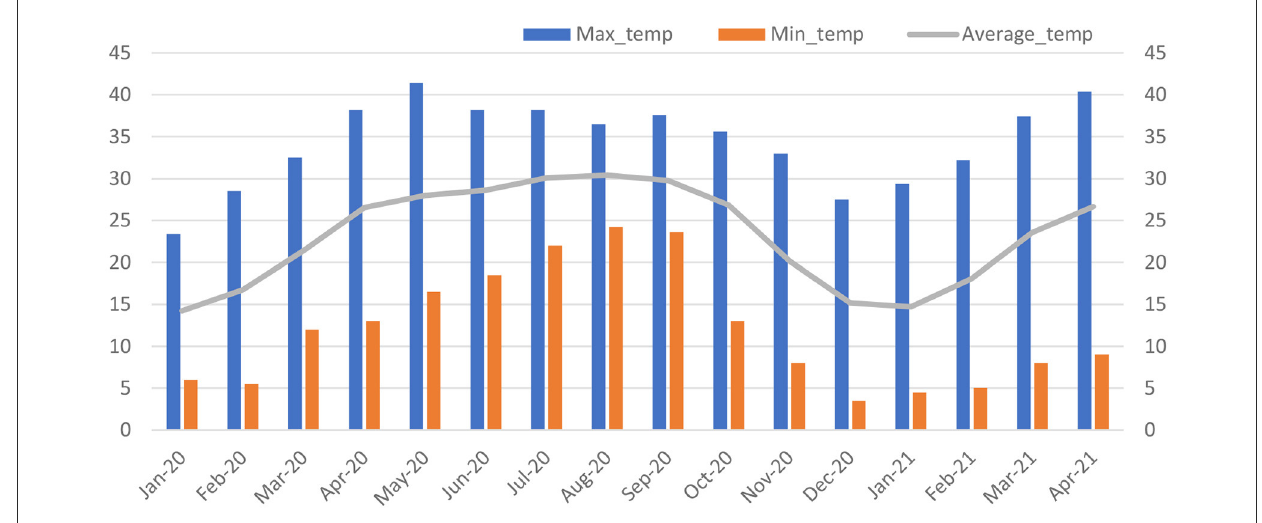
FIGURE2 Maximum, minimum, and average temperature in the study location. Source: directorate of Agricultural Research, Khajura, Banke, 2021.